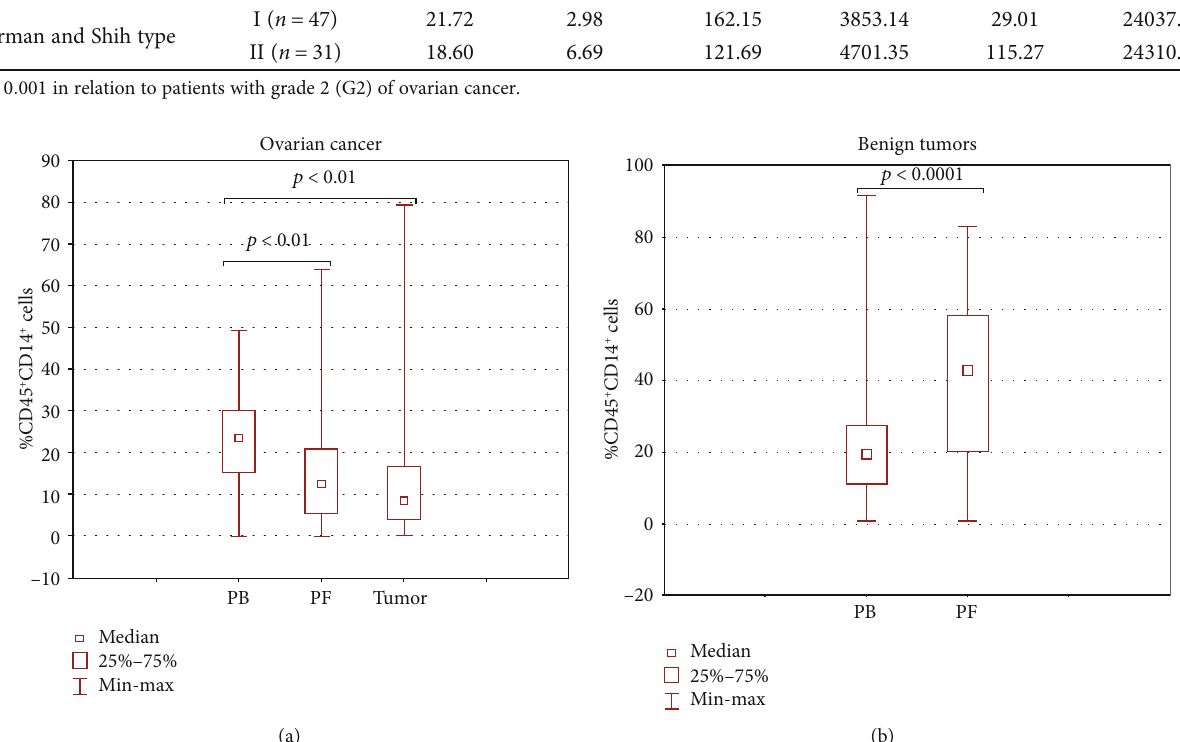
Table 3: Levels of IL-6 (pg/ml) in the plasma and PF of patients with di ff erent FIGO stages, grades, and Kurman-Shih types of ovarian cancer. Concentration of IL-6 (pg/ml) in ovarian cancer patients ( n = 78 ) I-II ( n = 24 ) FIGO stage